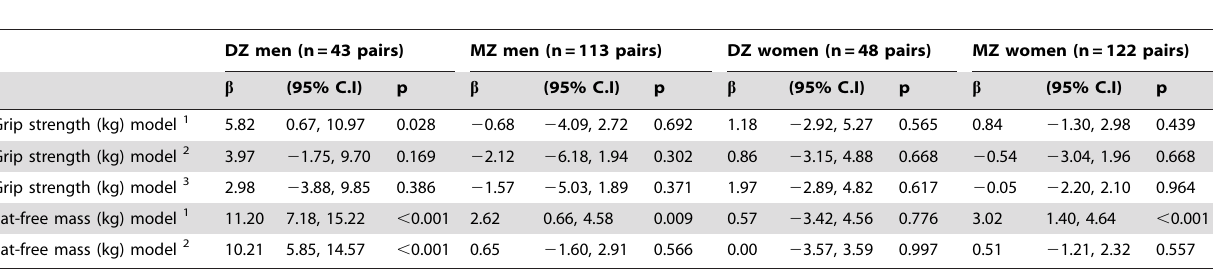
Table 4. Associations ( b –coefficients; 95% CI) between within-twin pair difference in birth weight (kg) and the within-twin pair difference in adult hand grip strength or fat free mass stratified by sex and zygosity.